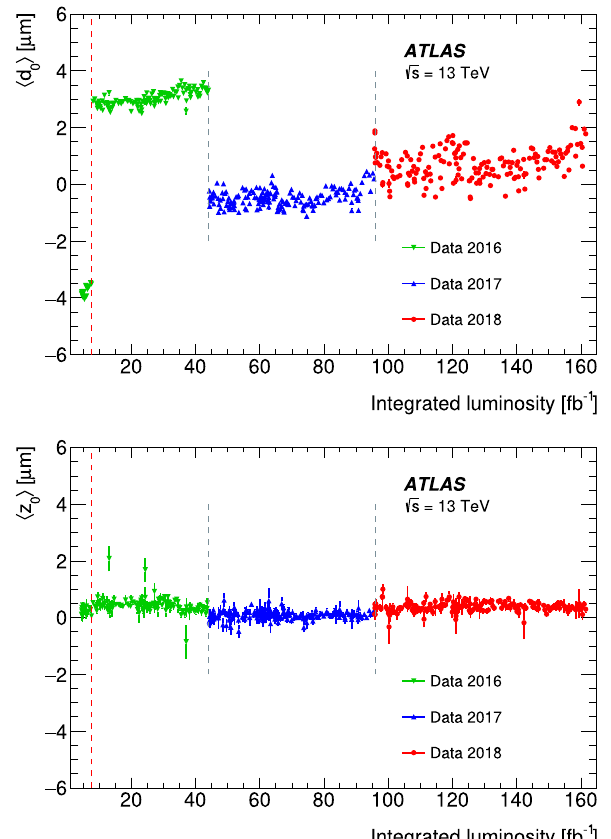
Fig. 24 The transverse (left) and longitudinal (right) impact parameter biases as function of the Run 2 delivered luminosity. The red dotted line indicate the change in the underlying ATLAS ID alignment geometry description. This splits the 2016 data in two periods. The grey dot- ted lines indicate the change of the data-taking years. The ∼ 4 fb − 1 corresponding to 2015 data are not shown in this plot. Only statistical uncertainties are